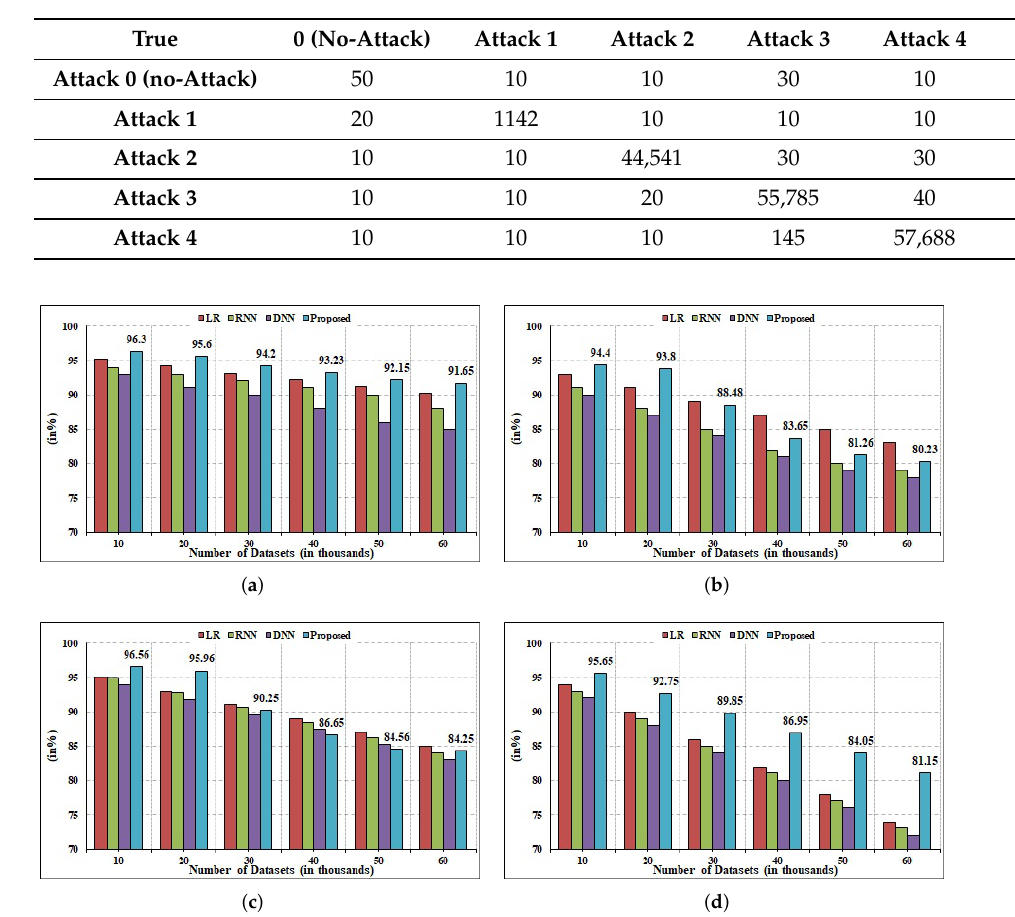
Figure 5. GRU-Model 1: Statistical Analysis. ( a ) Accuracy, ( b ) Precision, ( c ) Recall, ( d ) F1-measure.